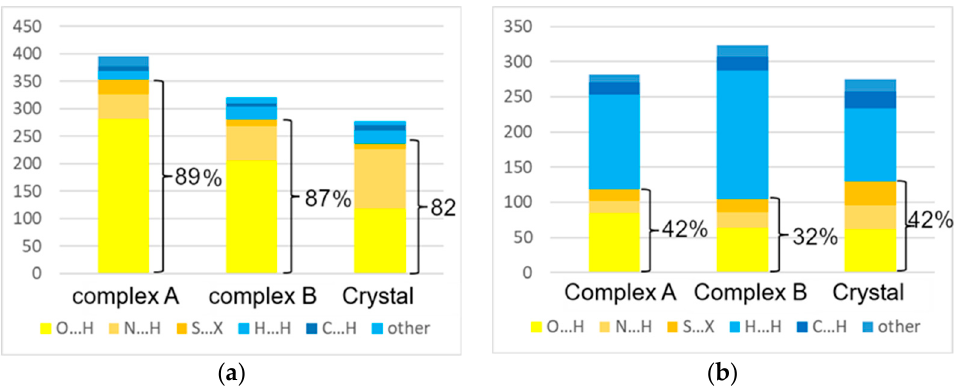
Figure 6. Contribution of hydrophobic (blue) and hydrophilic (yellow and orange) interactions to the ( a ) lattice energy and interaction energy in the tetragonal polymorph II and complexes A and B, and ( b ) to the surface of molecular Voronoi polyhedra.